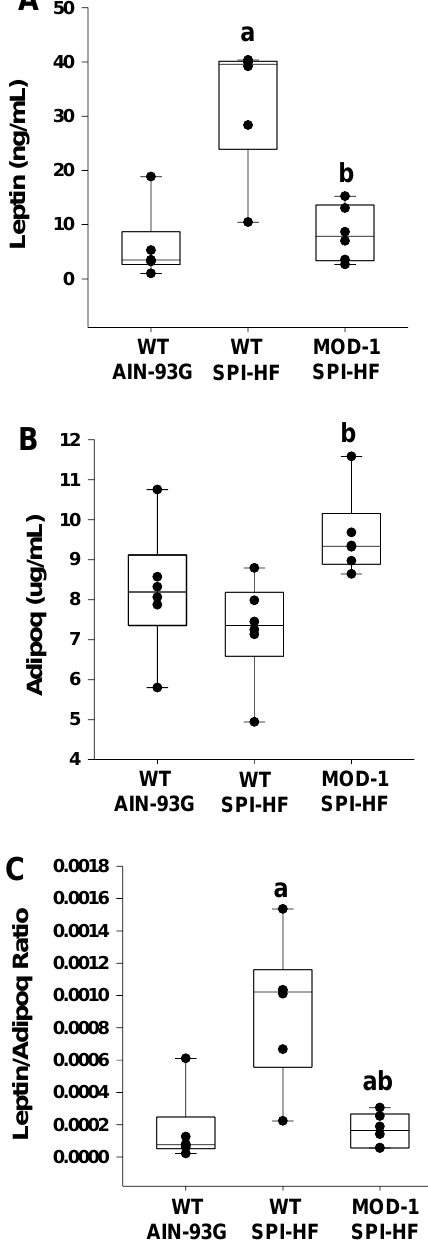
Figure 5. Serum ( A ) leptin, ( B ) adiponectin (Adipoq), and ( C ) leptin/adiponectin ratio for experimen- tal female mice ( n = 6/group). Box plots indicate the upper and lower quartiles, interquartile range, and median (middle line), with whiskers showing maximum and minimum points within 1.5 × the interquartile range. Significant differences are indicated by a and b; a indicates p < 0.05 compared to the WT AIN-93G group and b indicates p < 0.05 for WT SPI-HF vs. MOD-1 SPI-HF